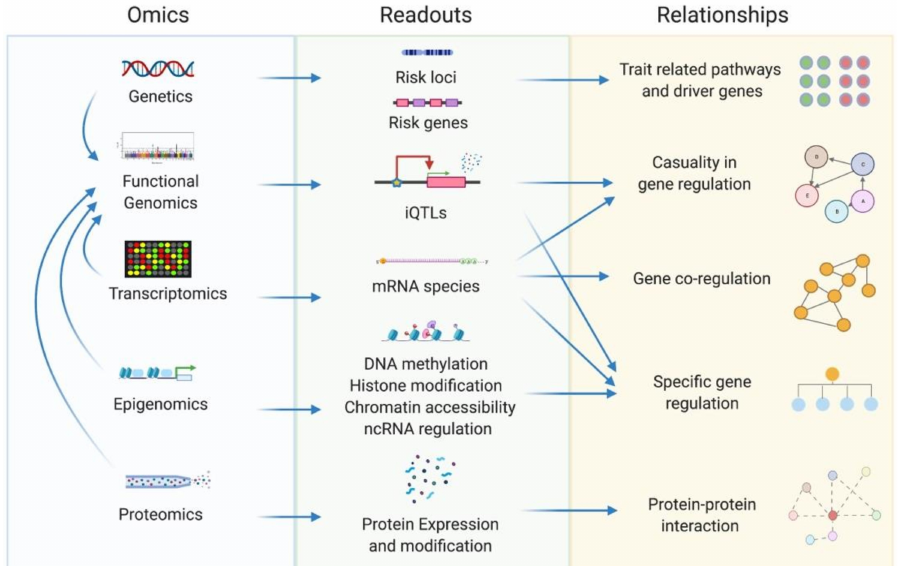
Figure 2. Extracting tissue and cell type-specific gene interaction relationships from multi-omics data. Genetics, functional genomics, transcriptomics, epigenomics, and proteomics are the most commonly used omics tools in obtaining gene interaction relationships. Genetic readouts can be used to infer trait-related pathways and driver genes, while readouts from other omics tools indicate gene regulatory relationships or protein-protein interactions. Particularly, intermediate phenotype QTLs (iQTLs) such as expression QTLs (eQTLs) or protein QTLs (pQTLs) from functional genomics data act as a bridge linking genetics and other omics by tissue-specific loci-gene regulatory relationship, thus enabling the interpretation of common variant loci in the non-coding areas of the